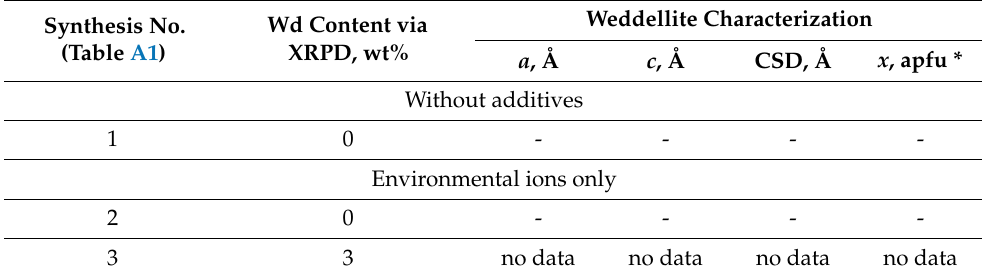
Table A2. The content of weddellite in the precipitate obtained via XRPD, unit cell parameters of weddellite and the content of zeolite water in it ( x